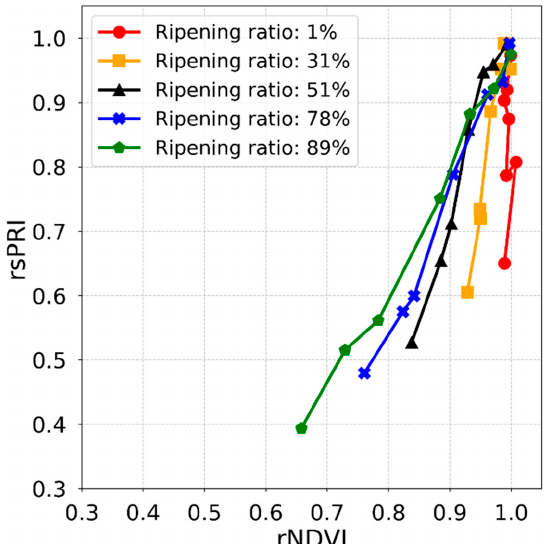
Figure 12. Different slopes between rNDVI and rsPRI after the heading stage depending on ripening ratio of paddy rice. rNDVI and rsPRI were calculated using data measured from field-spectrometers (canopy scale).